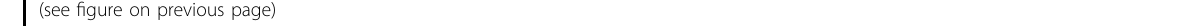
Fig. 7 Potential single-cell application and upgradability of CAPTURE. a t-SNE projection plot showing 20 major clusters by GRAPH-based classi fi cation. b – d t-SNE projection plots highlighting cells from DMSO-A375 ( b ), A375-R2 ( c ), and A375-R2- Δ bc2-1 ( d ). The red dotted lines outline representative clusters of enrichment. e Diagram of CAPTURE-v2 (version 2), which was upgraded from version 1 by upgrading the reporter to a 2 A peptides linked polycistronic reporter so that barcode frameshifting will switch different markers simultaneously. msfGFP monomeric super-folder GFP, PuroR puromycin resistance gene, HA hemagglutinin tag. f Schematic illustration of the reporter outcomes of CAPTURE-v2 at different stages. During barcoding, only the perfect barcoded (without frameshifting background) cells will be resistant to blasticidin selection, which will minimize the possible background. During capturing, only – 1 frameshifted barcodes will simultaneously frame out GFP and frame in PuroR-HA, which will make the cells resistant to puromycin to enable pre-enrichment for sorting. Additionally, detecting the PuroR-HA fusion expression using an anti-HA antibody by western blot helps con fi rm this outcome. BOI, a cell with barcode of interest. g Testing the puromycin sensitivity of CAPTURE-v2 barcoded cells with or without CRISPR targeting. Parental A375 cells were also included as a control. 1000 cells were seeded each well of the 24-well plate one night before adding puromycin at the indicated concentrations. h Determination of HA-PuroR expression by western blot. CAPTURE-v2 barcoded A375 cells with the indicated treatments were subjected to western blot. Tubulin was used as loading control. The asterisk indicated the position of full length of – 1 frameshifted expression product; the arrow indicated the T2A-cleaved PuroR-HA. i Enrichment of RFP + , GFP – cells in CAPTURE-v2 barcoded cells with indicated ratio spike-in of barcode of interest (BOI, here is BC2-v2) after CRISPR targeting and puromycin selection determined by fl ow cytometry. j The purity of isolated cells is determined by NGS. Cells isolated from spike-in experiments of i were subjected to amplicon sequencing of the barcode region. The targeted cell percentages were inferred by targeted read